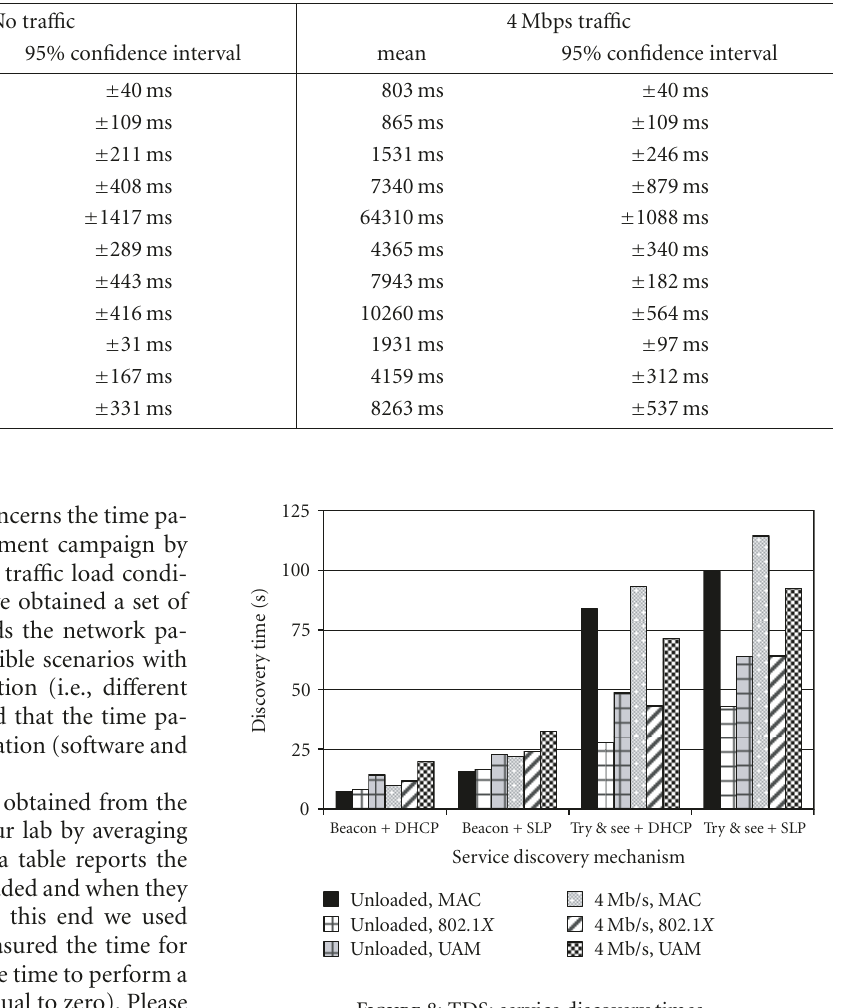
Figure 8: TDS: service discovery